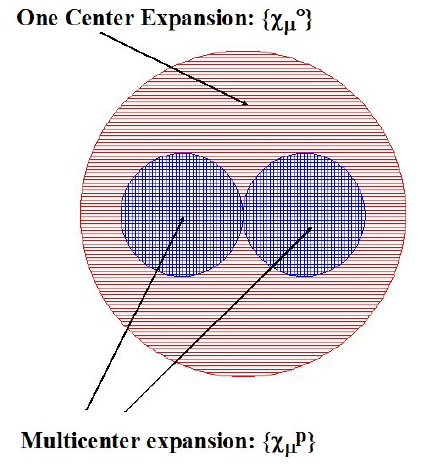
Figure 1. Multicenter (LCAO)